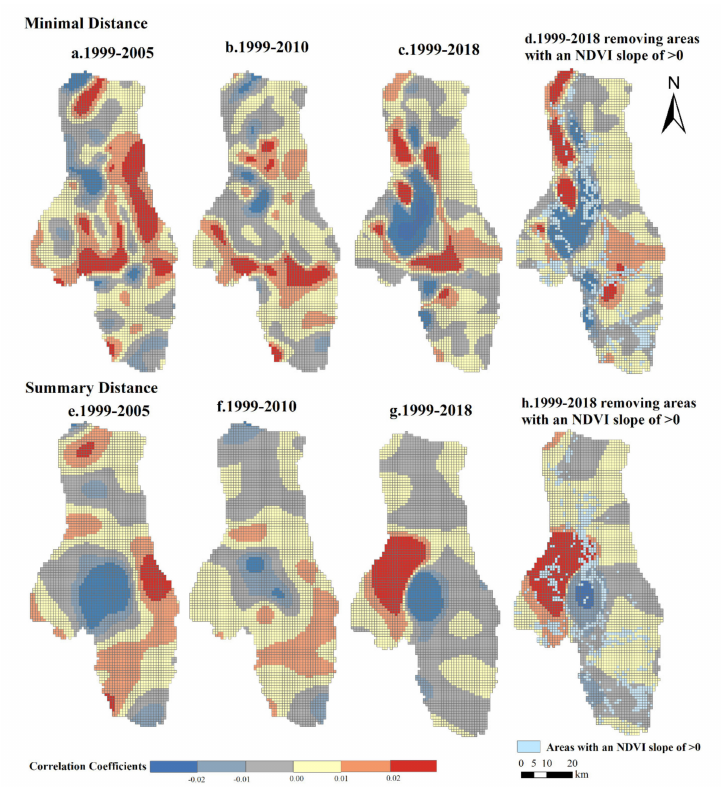
Figure 5. ( a – h ) Spatial patterns of correlation coe ffi cients between distance and vegetation changes. ( a – d ) Minimal and ( e – h ) summary distance in